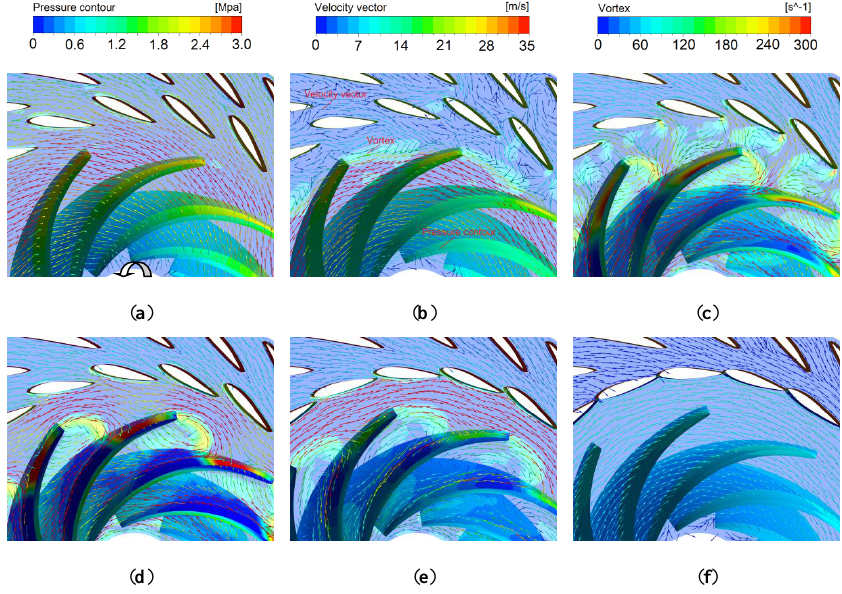
Figure 11. Flow fields in runner at different moments. ( a ) t = 0 s; ( b ) t = 6.5 s; ( c ) t = 10 s; ( d ) t = 12 s; ( e ) t = 20 s; ( f ) t = 33 s. Energies 2018 , 11 , x FOR PEER REVIEW